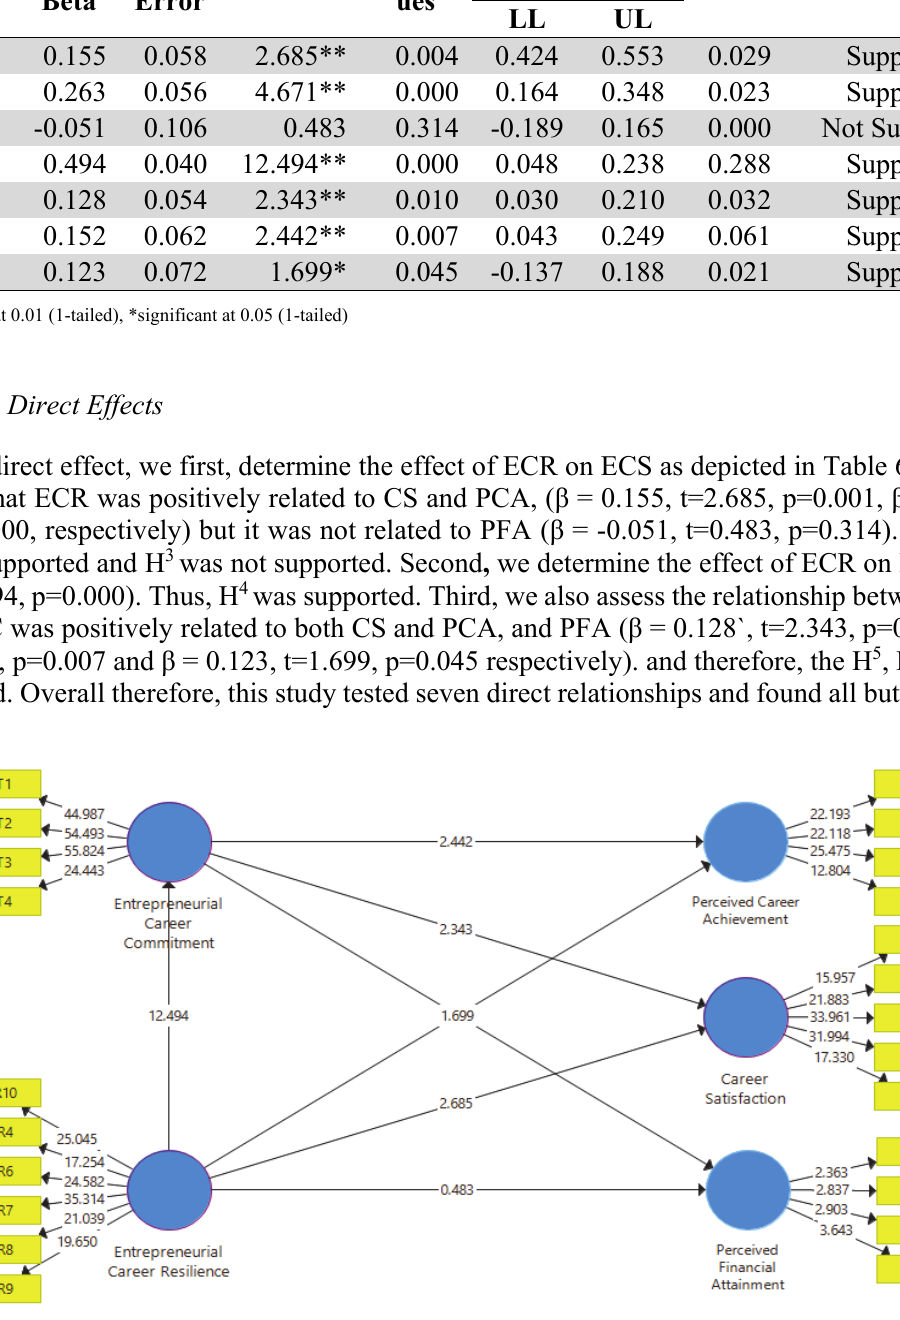
Structural Model Assessment (Direct Effect) Relationships